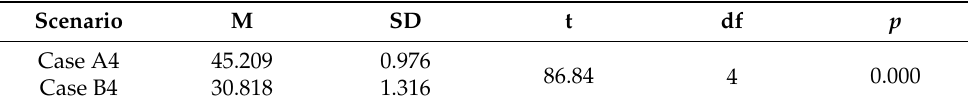
Table 16. Results of the paired sample t -test for scenario 4.